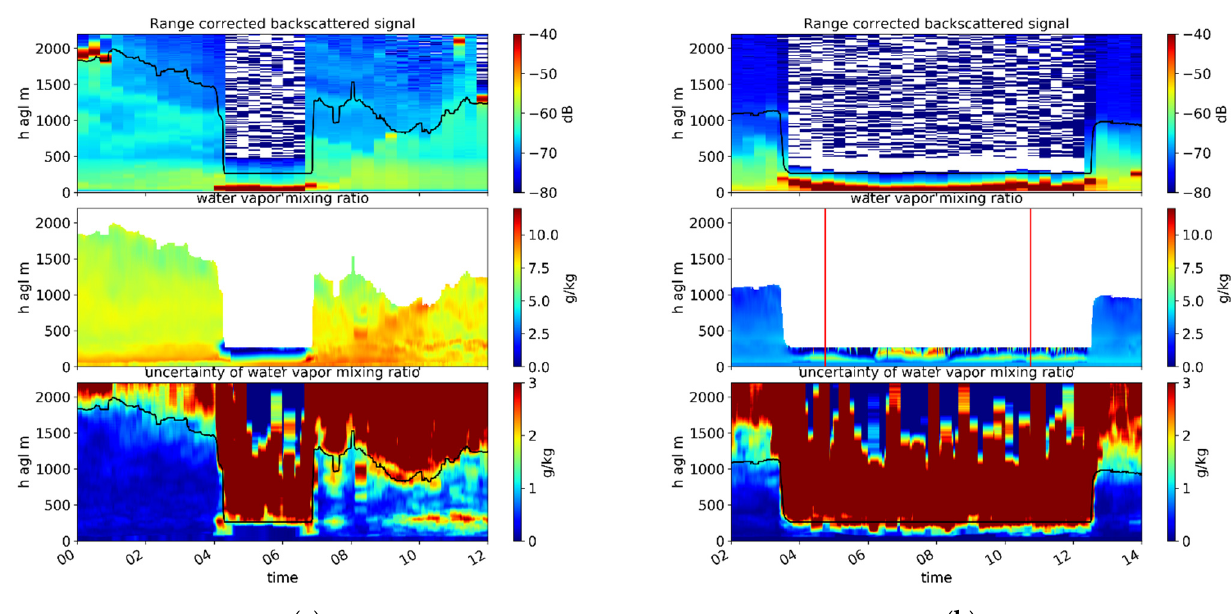
Figure 21. ( a ) BB-DIAL data for 16 June 2020. Top: range corrected backscatter (log scale). Middle: mixing ratio (g/kg). Bottom: reported BB-DIAL uncertainty (g/kg) for Cardington, ( b ) same as ( a ) but for the 04 February 2019 at Lindenberg from a similar BB-DIAL, the vertical red lines represent the radiosonde launch times, (Data provided by Dr Knist Christine DWD/Lindenberg).